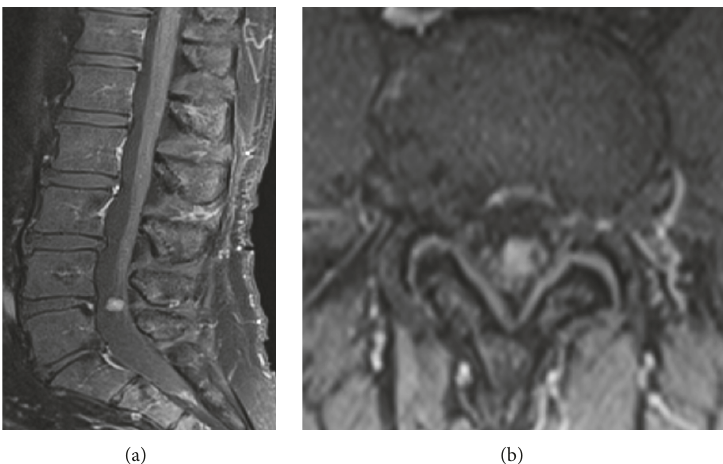
Figure 3: Illustrative case. A 61-year-old man presenting with anesthesia on the anterior portion of the right leg. (a) Preoperative MRI, sagittal sequence; (b) preoperative MRI, axial sequence. The patient underwent surgical intervention with NPhM; the schwannoma was found to have strict adherence with a sensitive root and to arise from a motor root; intraoperative stimulation showed high activation pattern of L4 (see video). Schwannoma was removed carefully and preservation of the nerve root was obtained. Postoperative course was